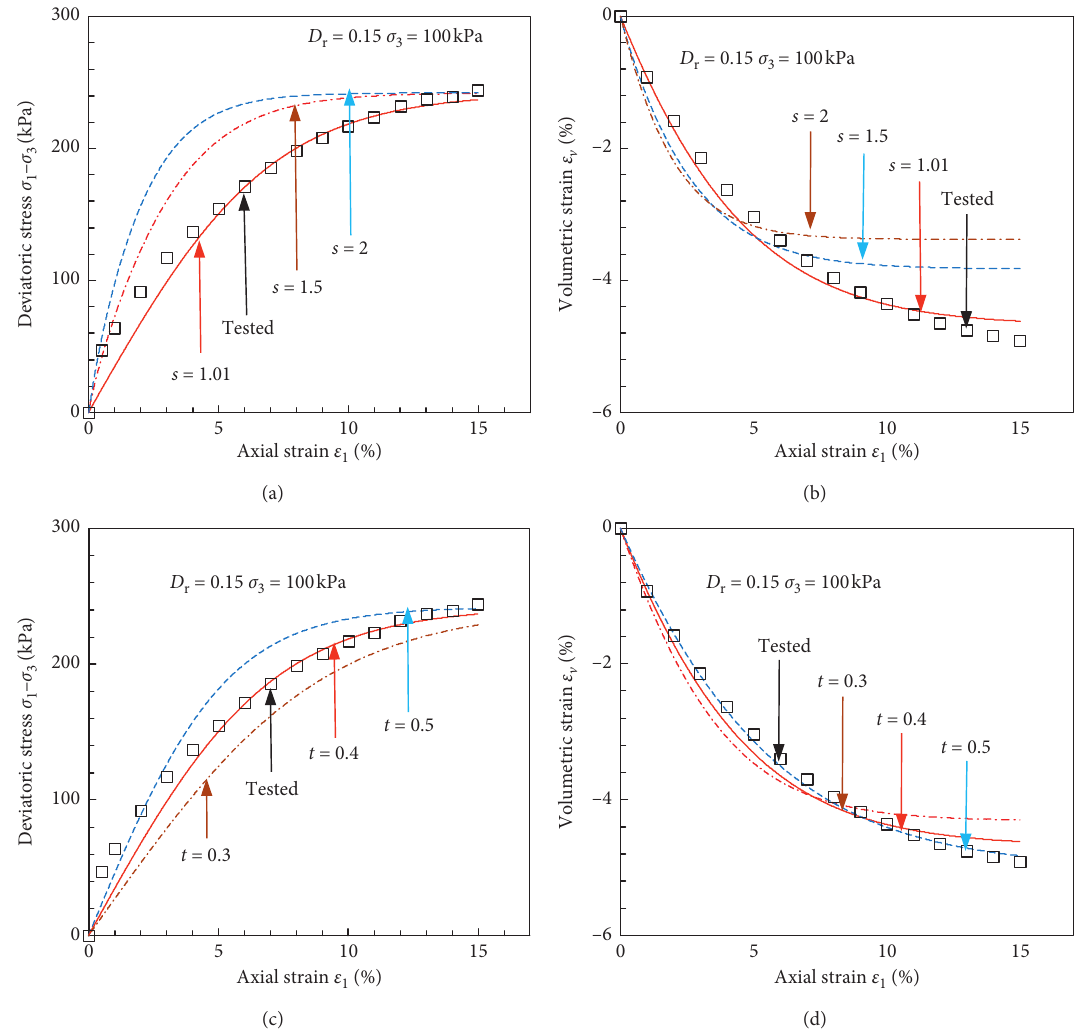
r to s and t . (a) D r - s . (b) D r - t .